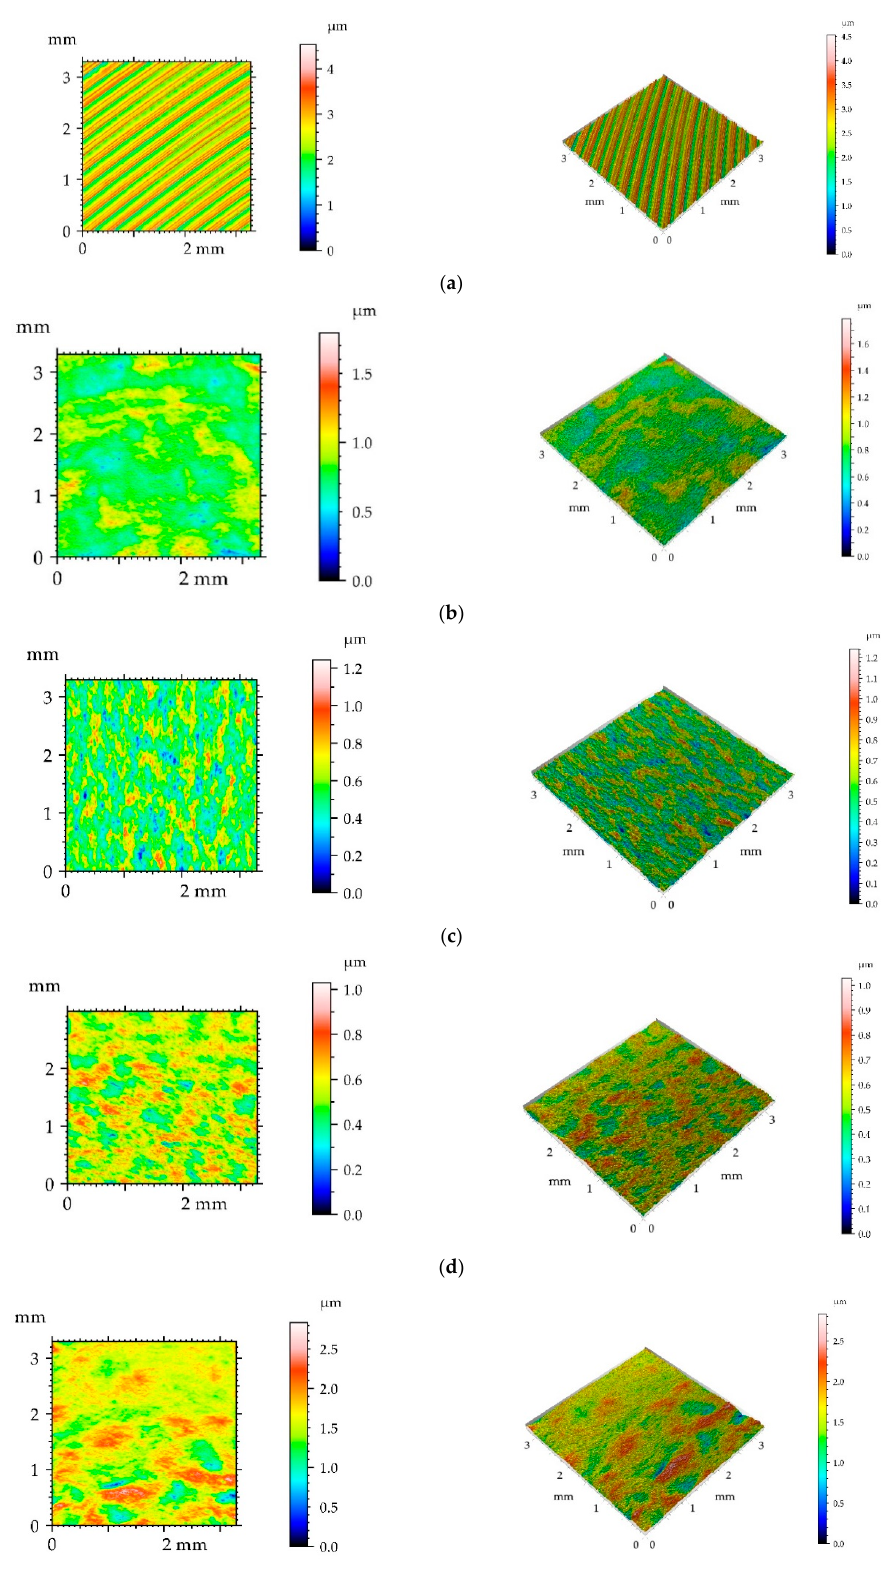
Figure 2 presents isometric views and contour plots of machined samples.